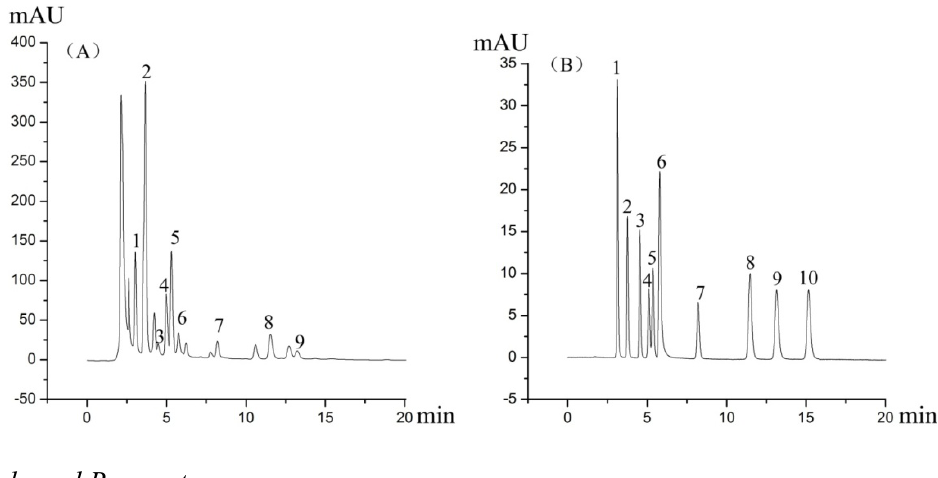
Figure 5. HPLC chromatograms of ( A ) C. cicadae (Pop CCLTL); ( B ) mixed